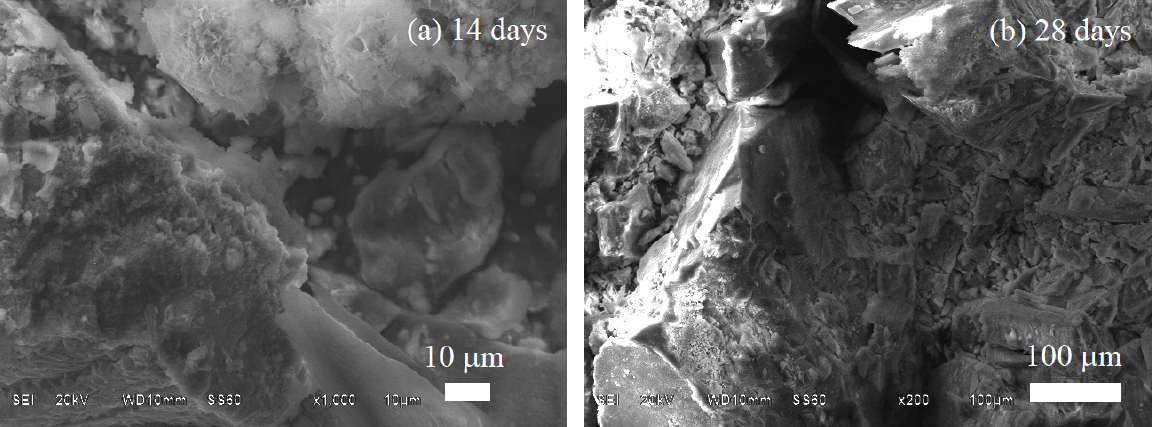
Figure 11. Scaffold SEM analysis for BG70-PLA30 after ( a ) 14 days and ( b ) 28 days of immersion in PBS. Table 6. EDS chemical analysis for BG-PLA composites after immersion in PBS.